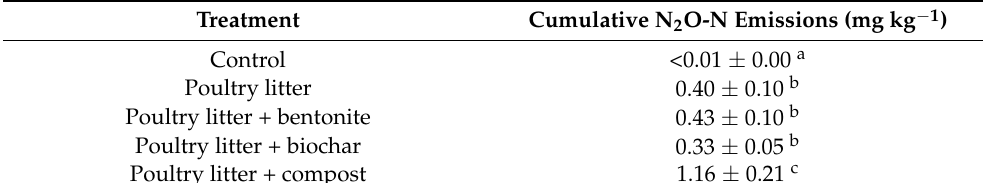
Table 3. Cumulative N 2 O fluxes (mean ± SD; n = 4) of the in vitro experiment in the laboratory (per kg of dry soil-poultry litter blend). Statistical analyses: one-way ANOVA with Fisher’s LSD post-hoc test. Differences between treatments at p < 0.05 significance are marked by different letters.